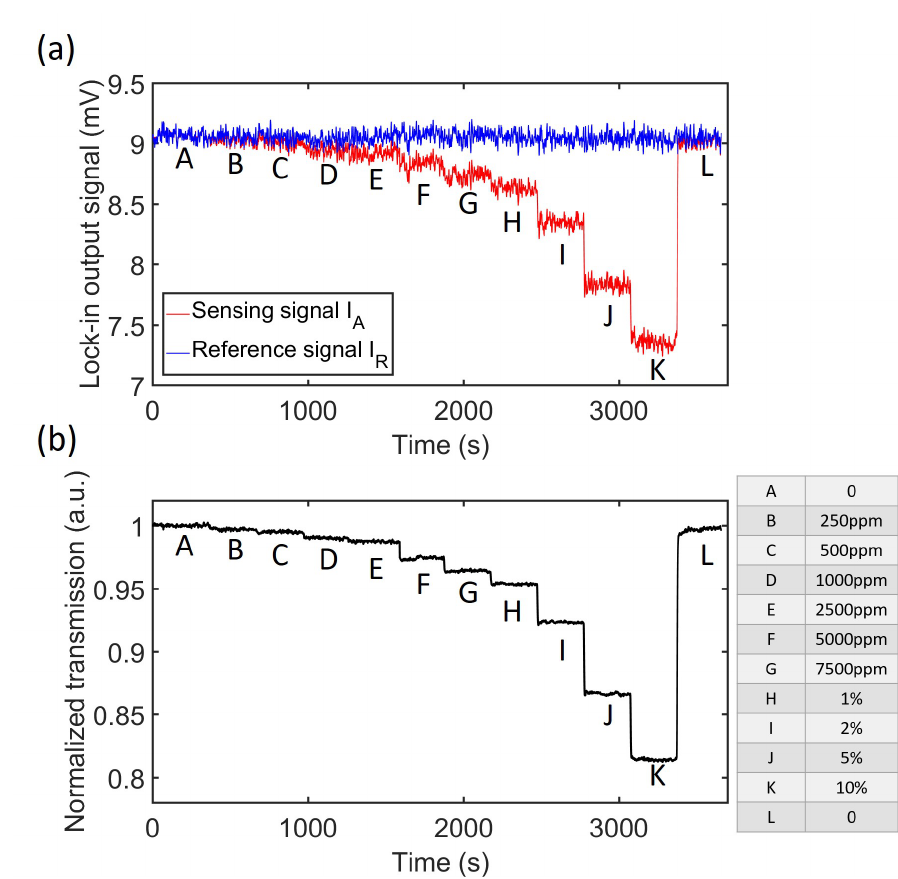
Figure 8. ( a ) Response of both sensing signal and reference signal to CO 2 concentration steps, the sensing and reference signal exhibit a strong correlation. ( b ) Normalized transmission, obtained by dividing the sensing signal with the reference signal. The CO 2 concentration steps are listed on the right side.